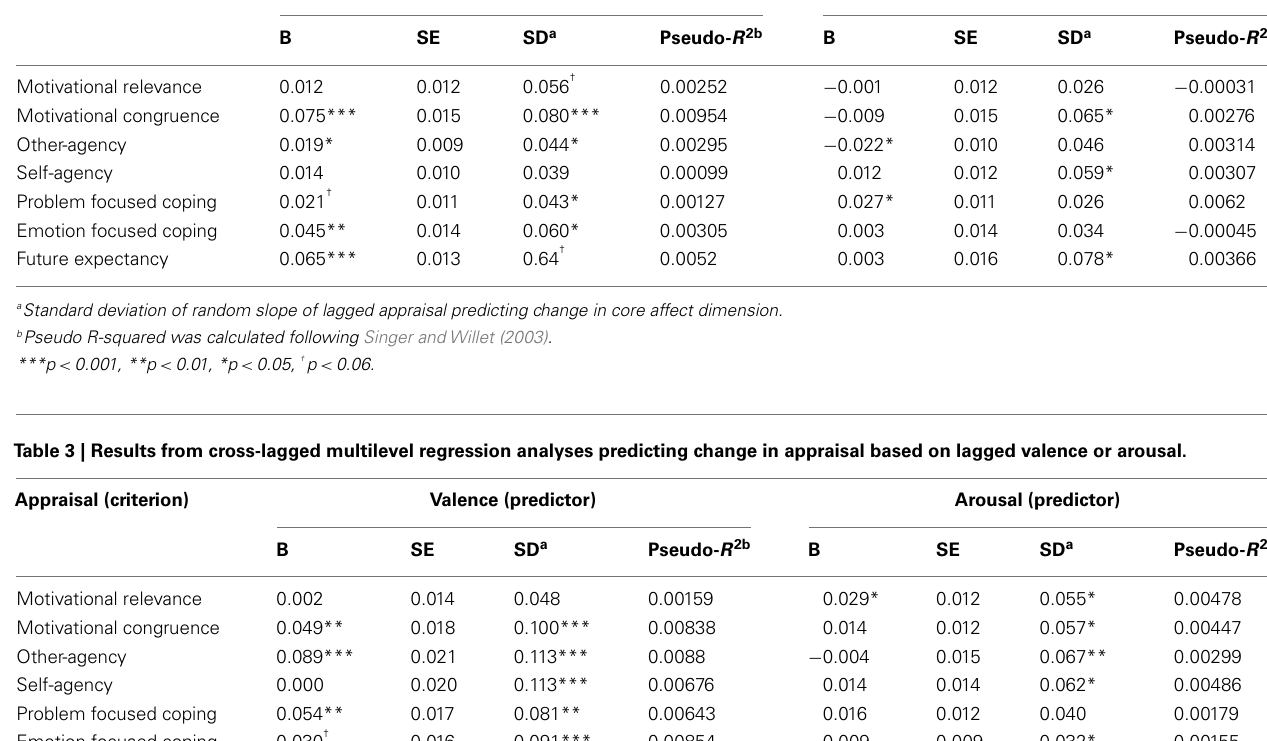
Table 2 | Results from cross-lagged multilevel regression analyses predicting change in valence or arousal on the basis of lagged appraisal. Appraisal (predictor)